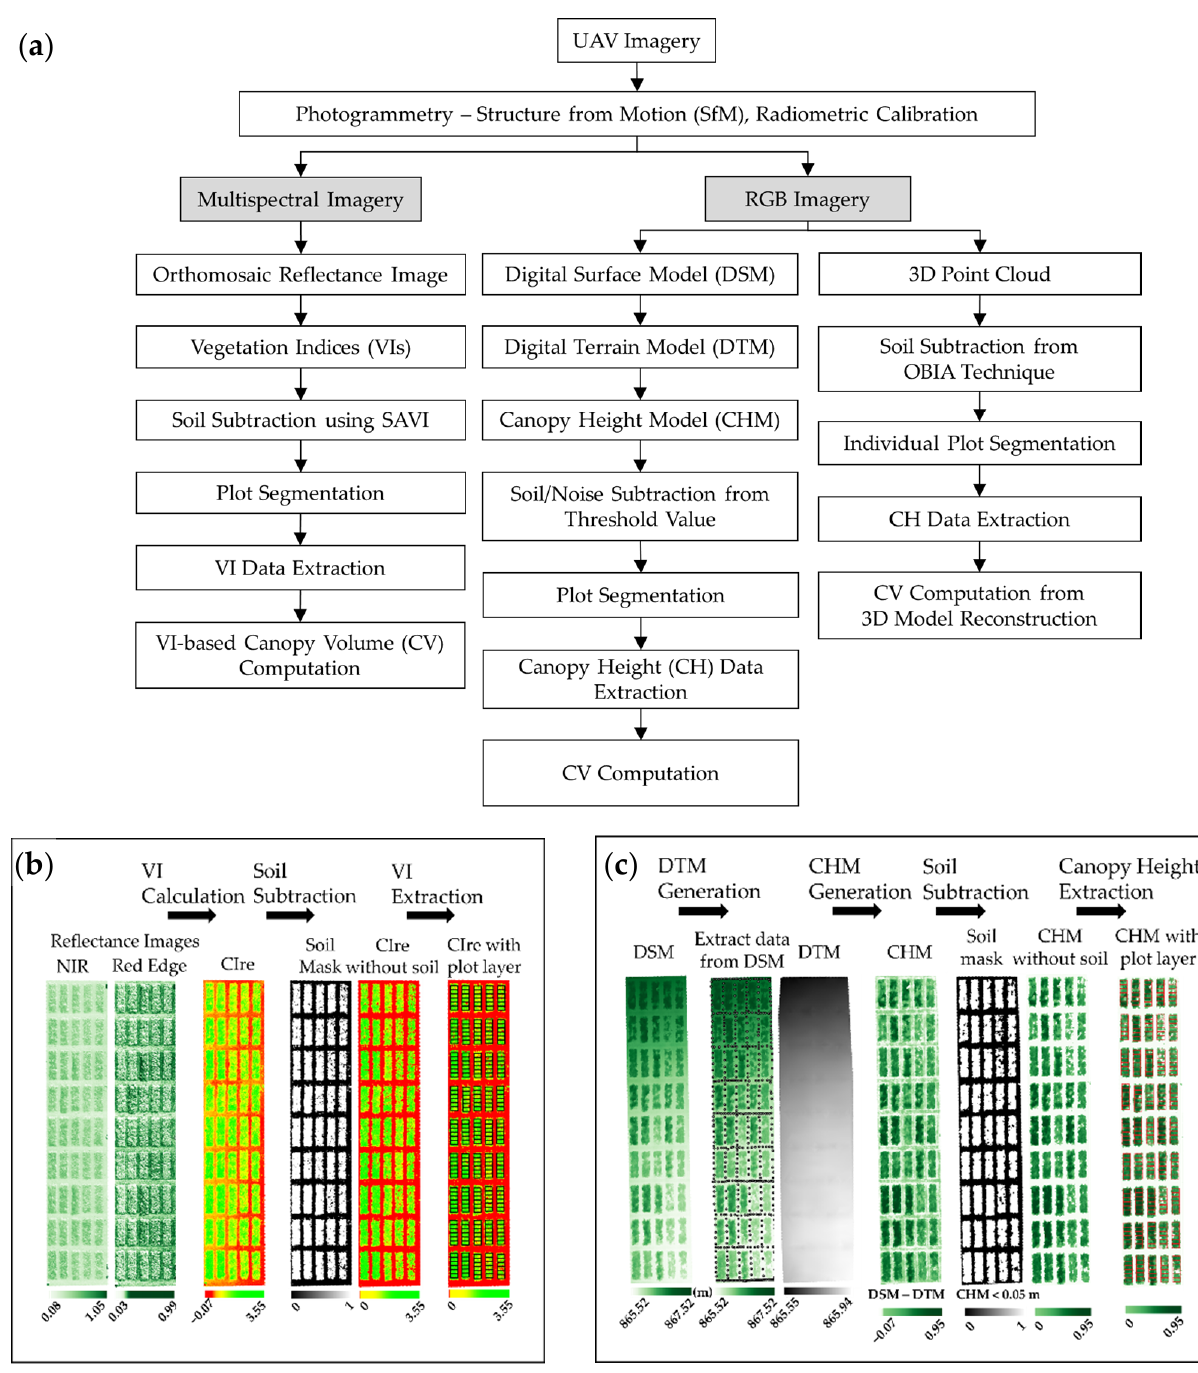
Figure 2. Image processing pipeline: ( a ) flowchart of overall pipelines used to extract digital traits in this study; ( b ) a VI data extraction pipeline; ( c ) a canopy height data extraction from DSM pipe- line. SAVI: soil-adjusted vegetation index; OBIA: object-based image analysis; NIR: near-infrared; RE: red edge; CIre: chlorophyll index red edge.